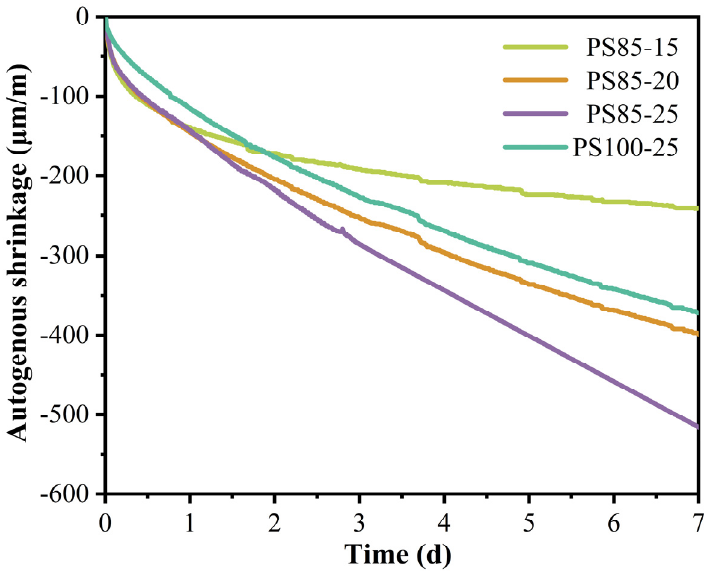
Figure 4. The autogenous shrinkage of WUFA-PS and PS-based geopolymer mortars with different amounts of activators.